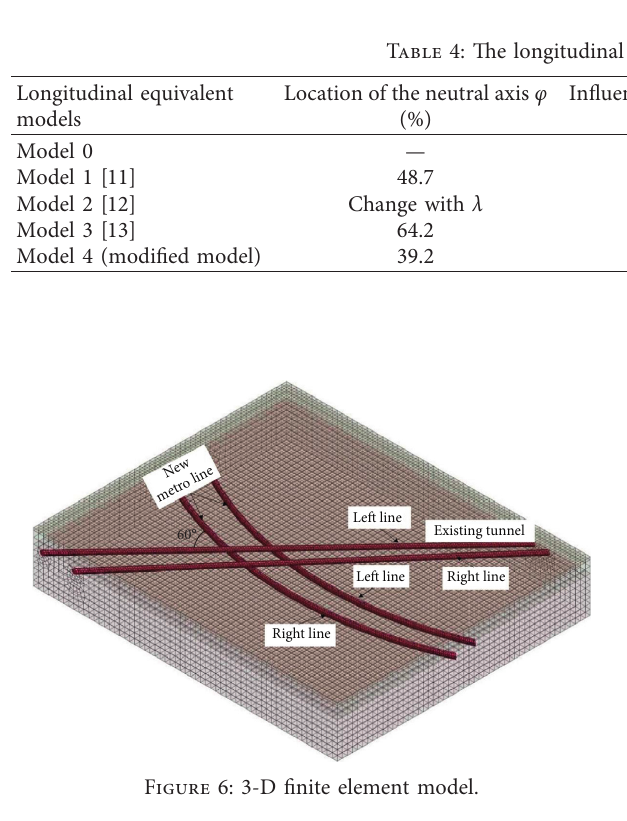
Figure 8: The crown settlement curves of the existing tunnel after the completion of new metro line.